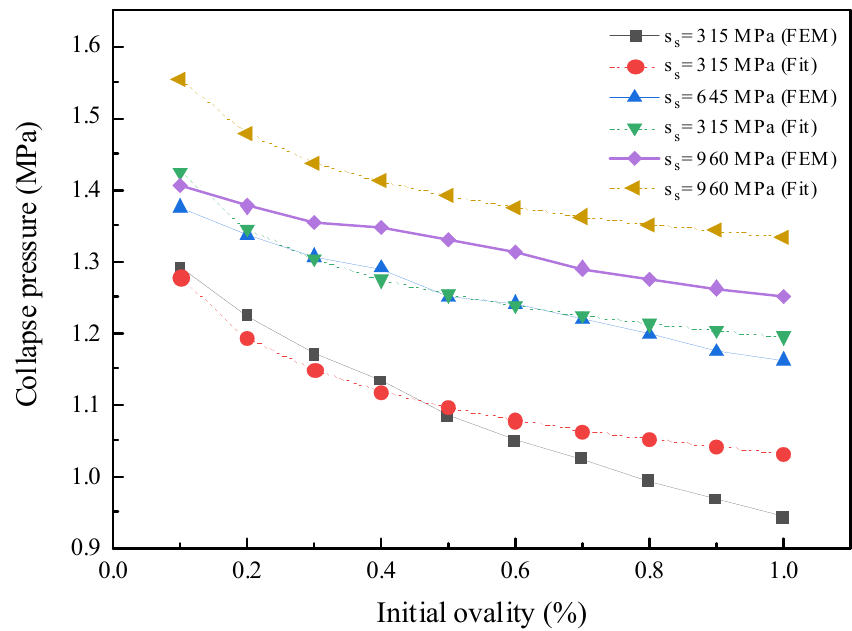
Figure 19. Comparison of FEM and fitting results with respect to different initial ovality.